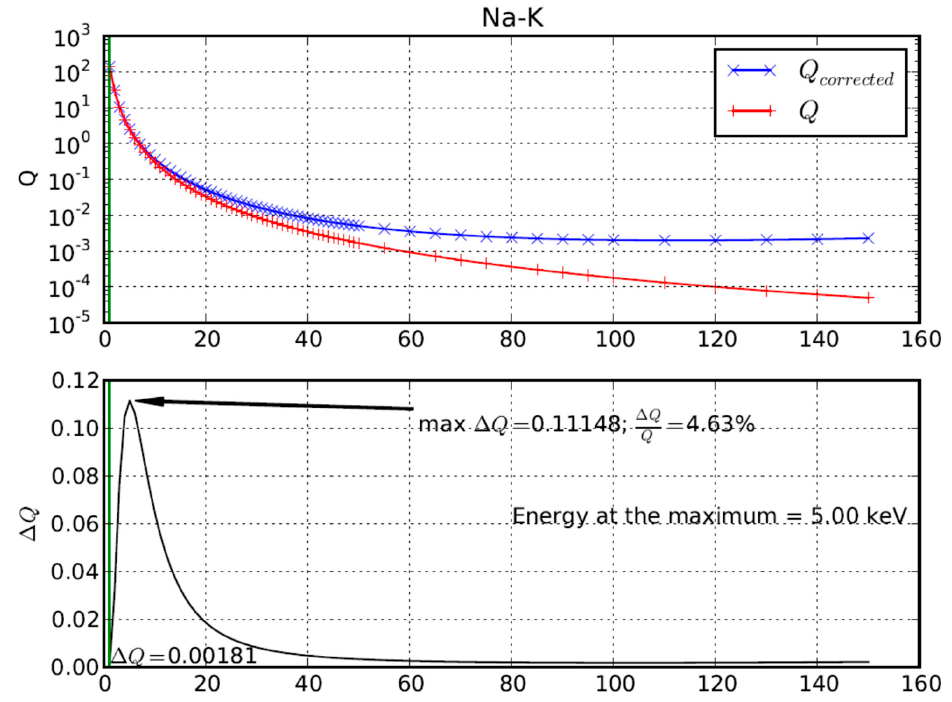
Figure 5. Top panel: Q corrected and Q for the line Na K α 1 as a function of the excitation energy in keV. Figure 5. Top panel: 𝑄 (cid:3030)(cid:3042)(cid:3045)(cid:3045)(cid:3032)(cid:3030)(cid:3047)(cid:3032)(cid:3031) and 𝑄 for the line Na 𝐾𝛼 (cid:2869) as a function of the excitation energy in Lower panel: The absolute correction ∆ Q = Q corrected − Q was relevant within a restricted interval. The keV. Lower panel: The absolute correction ∆𝑄 = 𝑄 (cid:3030)(cid:3042)(cid:3045)(cid:3045)(cid:3032)(cid:3030)(cid:3047)(cid:3032)(cid:3031) − 𝑄 was relevant within a restricted in- maximum extent of the correction occurred at 5 keV and represented 4.63% of the uncorrected terval. The maximum extent of the correction occurred at 5 keV and represented 4.63% of the un- Figure 5. Top panel: 𝑄 (cid:3030)(cid:3042)(cid:3045)(cid:3045)(cid:3032)(cid:3030)(cid:3047)(cid:3032)(cid:3031) and 𝑄 for the line Na 𝐾𝛼 (cid:2869) as a function of the excitation energy in corrected line. keV. Lower panel: The absolute correction ∆𝑄 = 𝑄 (cid:3030)(cid:3042)(cid:3045)(cid:3045)(cid:3032)(cid:3030)(cid:3047)(cid:3032)(cid:3031) − 𝑄 was relevant within a restricted in- terval. The maximum extent of the correction occurred at 5 keV and represented 4.63% of the un- corrected line.